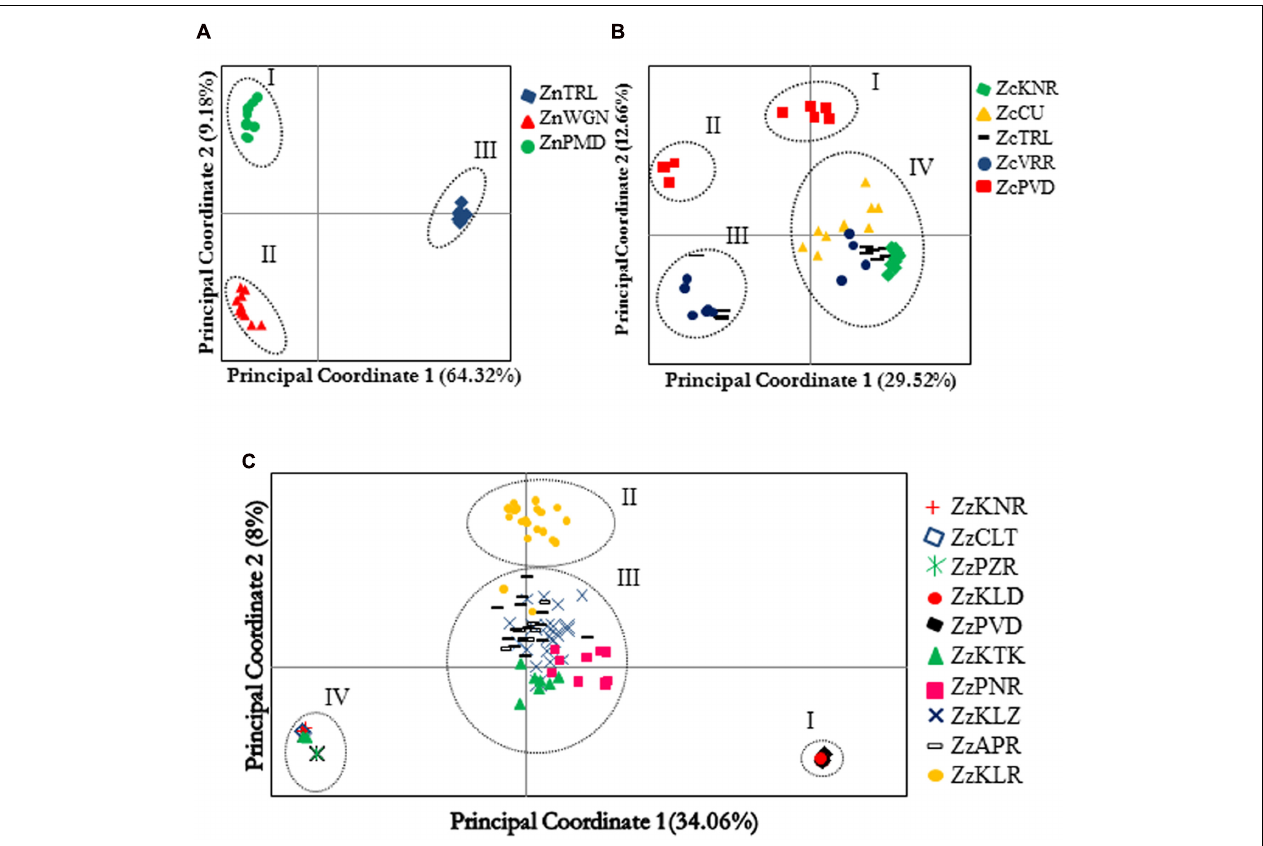
FIGURE 3 | Principal component analysis of the individuals belonging to different populations of Zingiber neesanum (A) , Zingiber nimmonii (B) , and Z. zerumbet (C) based on amplified fragment length polymorphism data. Clusters identified in each species are numbered.